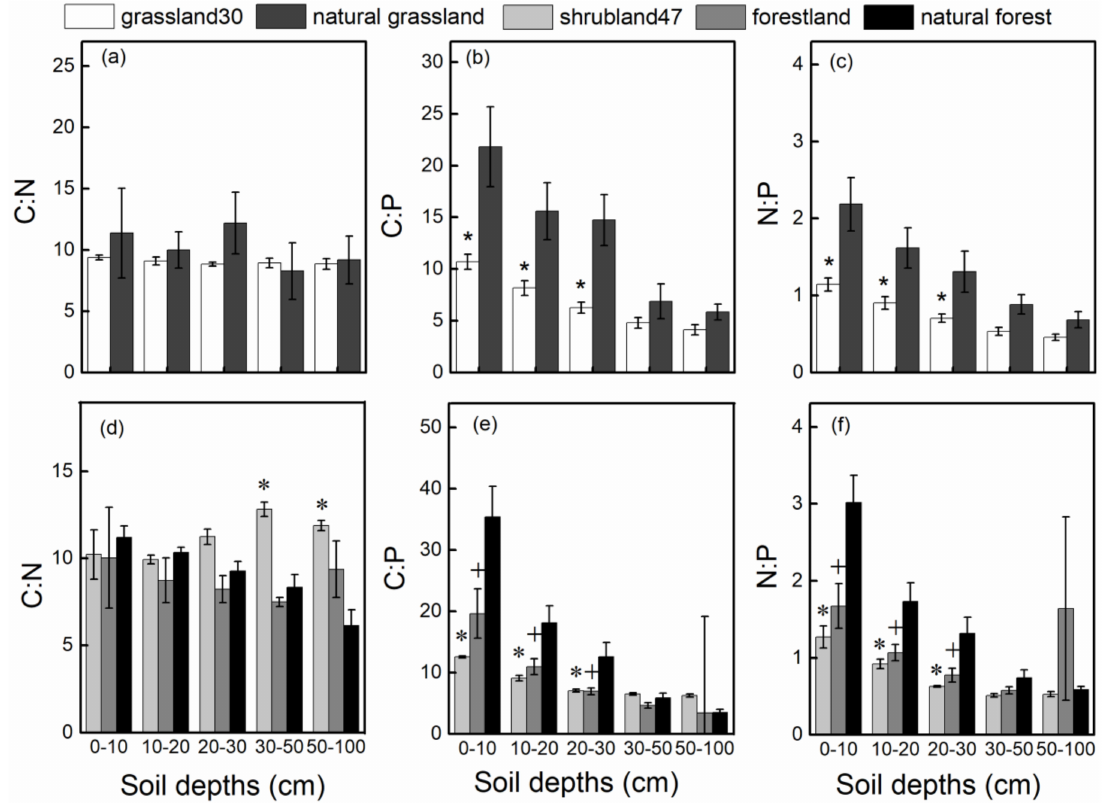
Figure 5. Stoichiometry of soil organic carbon (SOC), soil total nitrogen (TN), and soil total phosphorus (TP) at different soil depths in grassland at 30 years compared to that of natural grassland, and those of shrubland at 47 years and forestland at 56 years compared to that of natural forestland. Note: values are mean ± standard error. ( a – c ) means the C:N, C:P and N:P at different soil depths in grassland30 compared to those of natural grassland. ( d – f ) means the C:N, C:P and N:P at different soil